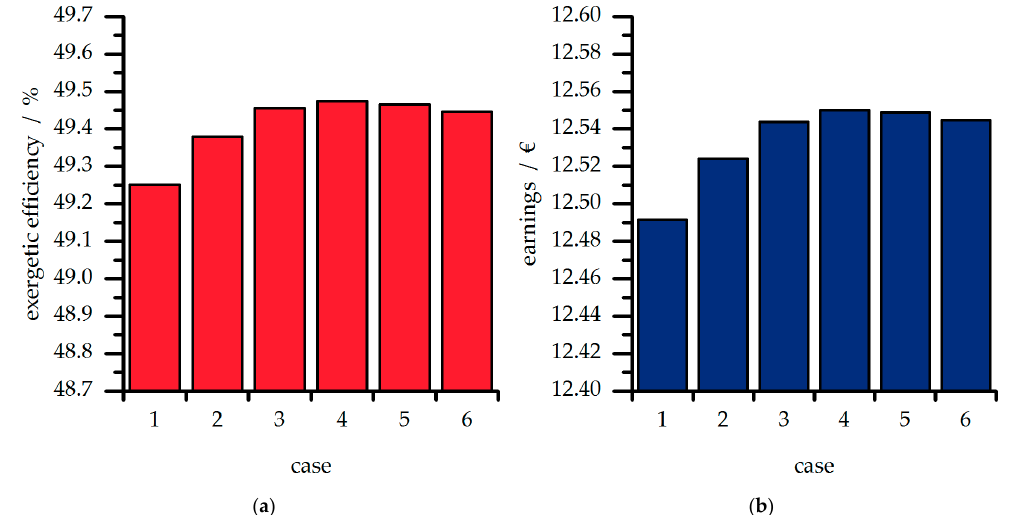
Figure 8. Annual mean exergetic efficiency ( a ) and annual revenues ( b ) for different cases of combined heat extraction concepts.